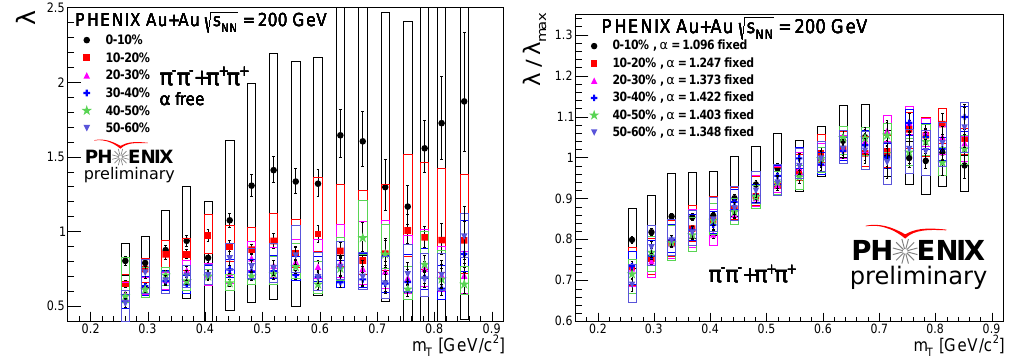
Figure 6. The λ ( m T ) function in the different centrality ranges ( left ); The normalized λ ( m T ) function with fixed α = (cid:104) α (cid:105) value ( right ). The statistical errors are shown with errorbars and the systematical uncertainties boxes.